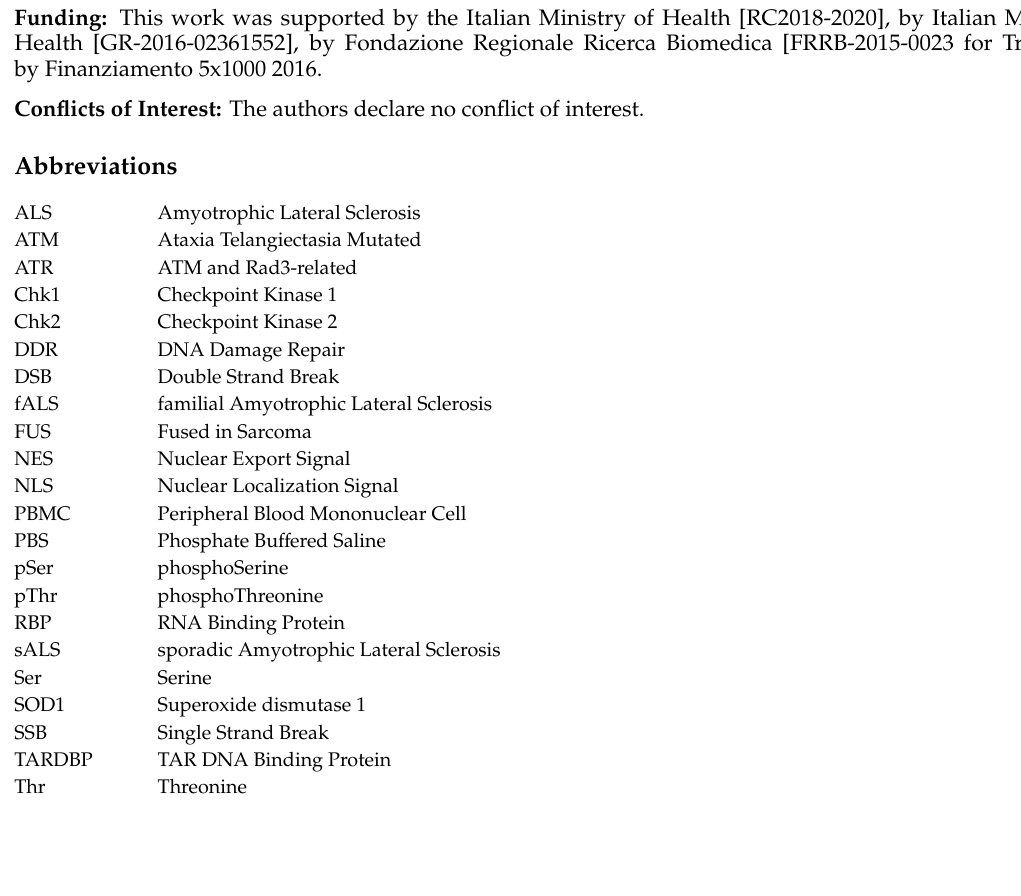
Figure S1: Aggregation of SOD1 in SH-SY5Y cells treated with H 2 O 2 . Confocal analysis of SOD1 localization in SH-SY5Y treated